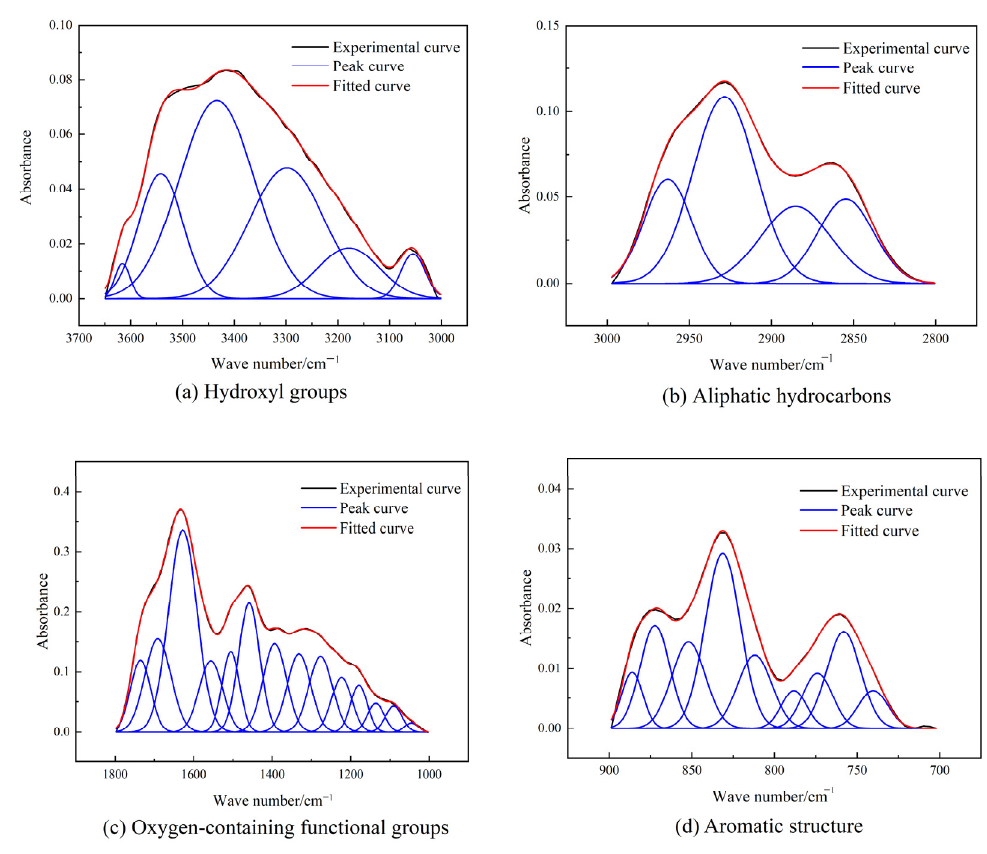
Figure 6. FTIR spectra of different functional groups of Kerjian coal ( a : Hydroxyl groups, b : Aliphatic hydrocarbons, c : Oxygen-containing functional groups, d : Aromatic structure). Table 8. Hydroxyl group parameters of Kerjian coal.